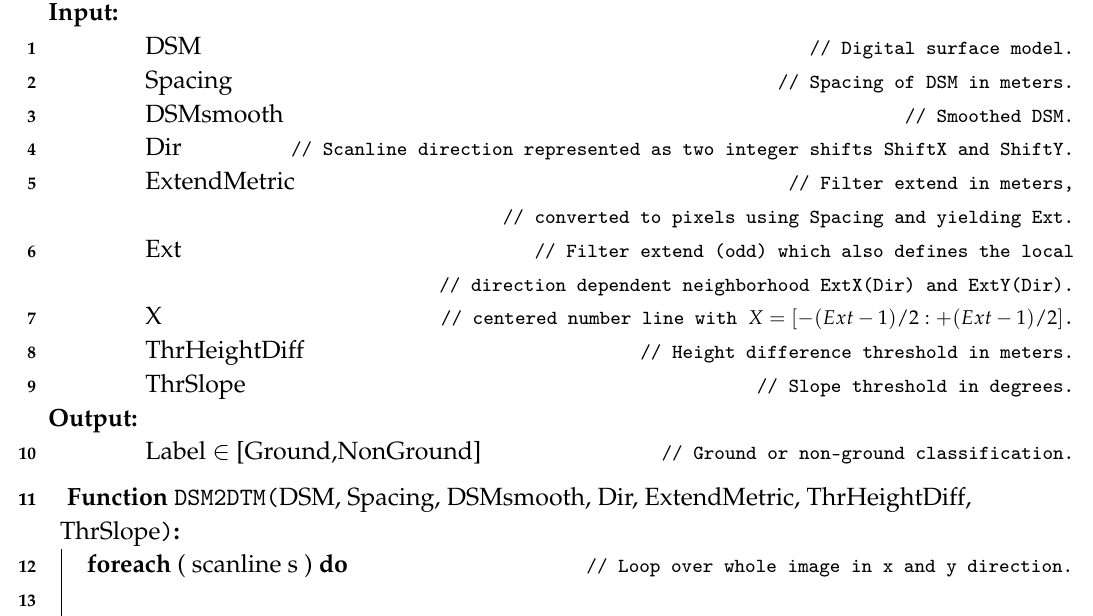
Algorithm 1: Multi-directional slope dependent DTM